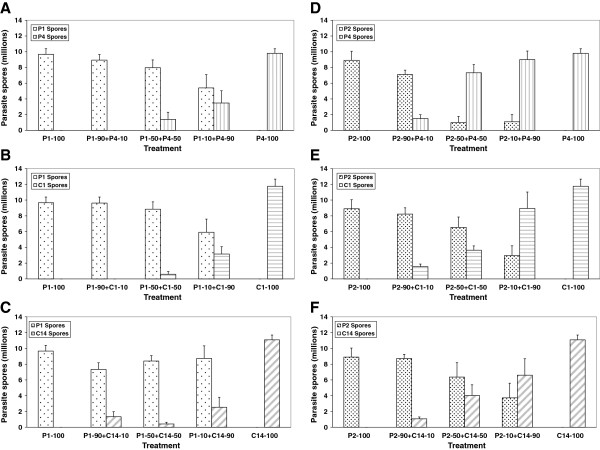
Lifetime spore production of an infection (parasite fitness) in single and mixed infections. Lifetime spore production of an infection (parasite fitness) in single and mixed infections by the parasite isolates/clones (A) P1 and P4 (B) P1 and C1 (C) P1 and C14 (D) P2 and P4 (E) P2 and C1, and (F) P2 and C14. Error bars are standard errors.